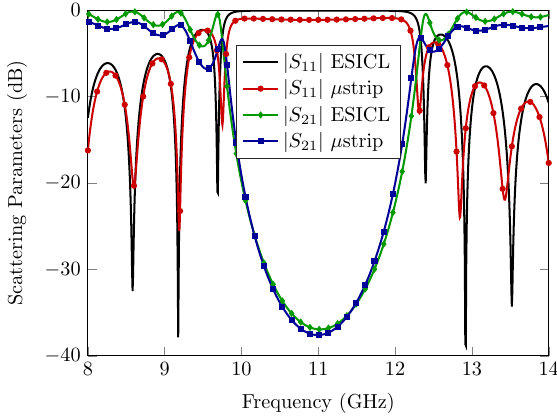
Figure 11. Comparison of simulated results for the same continuous profile filter with ESICL and microstrip